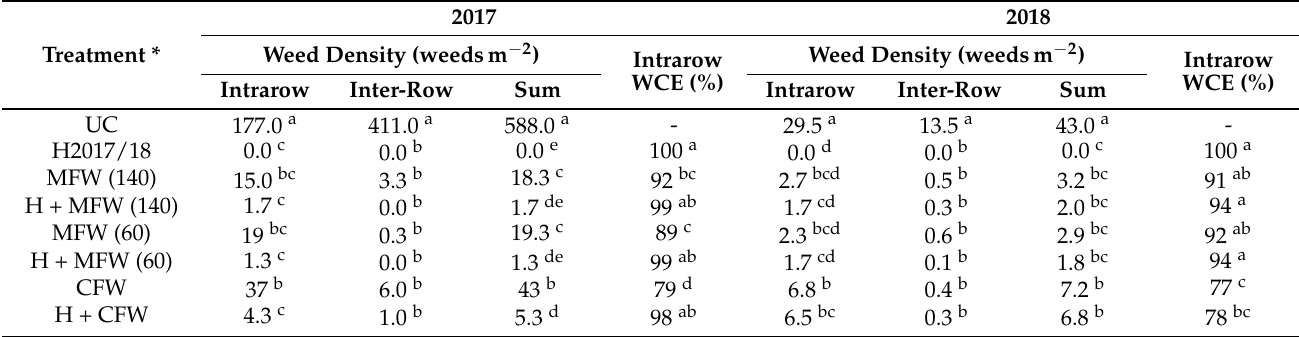
* UC: Untreated Control, H: Herbicide spraying, MFW (140): Motorized finger weeder fast speed, MFW (60): Motorized finger weeder slow speed, CFW: Conventional finger weeder Inter-row hoeing showed similar results as the intra-row with all treatments being different than the control; however, no differences were found between any of the treat- ments. The goosefoot sweeps eliminated most of the weed plants growing between the sugar beet rows In 2017, weed densities of 1.7 and 1.3 plants m − 2 were recorded for the H + MFW (140) and the H + MFW (60) treatments, respectively. Slightly higher weed densities of 5.3 plants m − 2 were found in the H + CFW treatment, but the results were not different compared to the combined methods H + MFW (140) and H + MFW